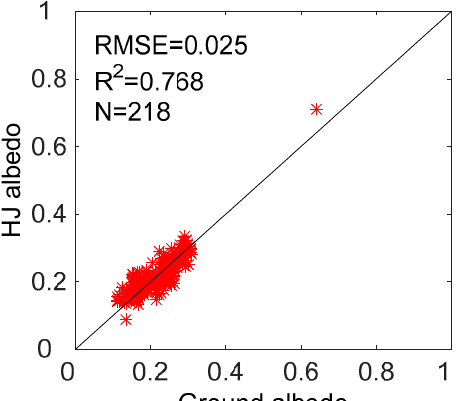
Figure 2. The comparison between HJ pixel albedo and ground-observed albedo in the experimental area.